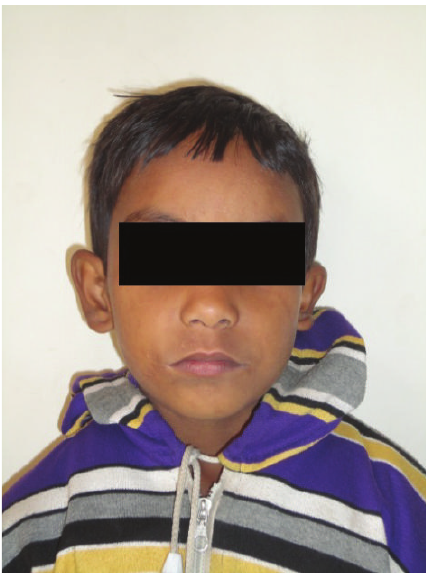
Figure 3: Two-month postsurgery photograph with symmetrical commissure.